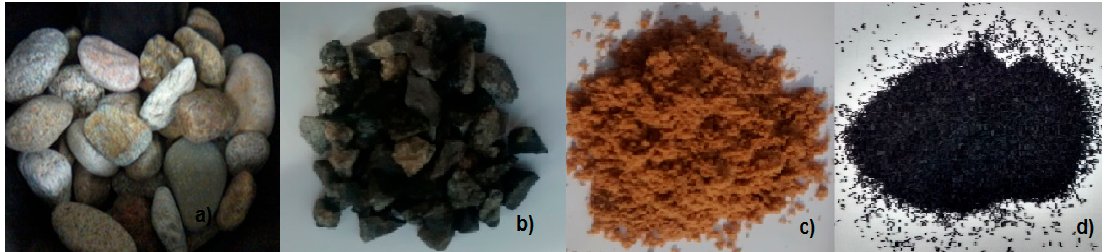
Figure 3. Materials used in the filter: ( a ) rolled pebbles; ( b ) gravel; ( c ) sand; ( d ) granular activated carbon (GAC). Table 1. Parameters and the reference methodologies used to characterize the filter materials.